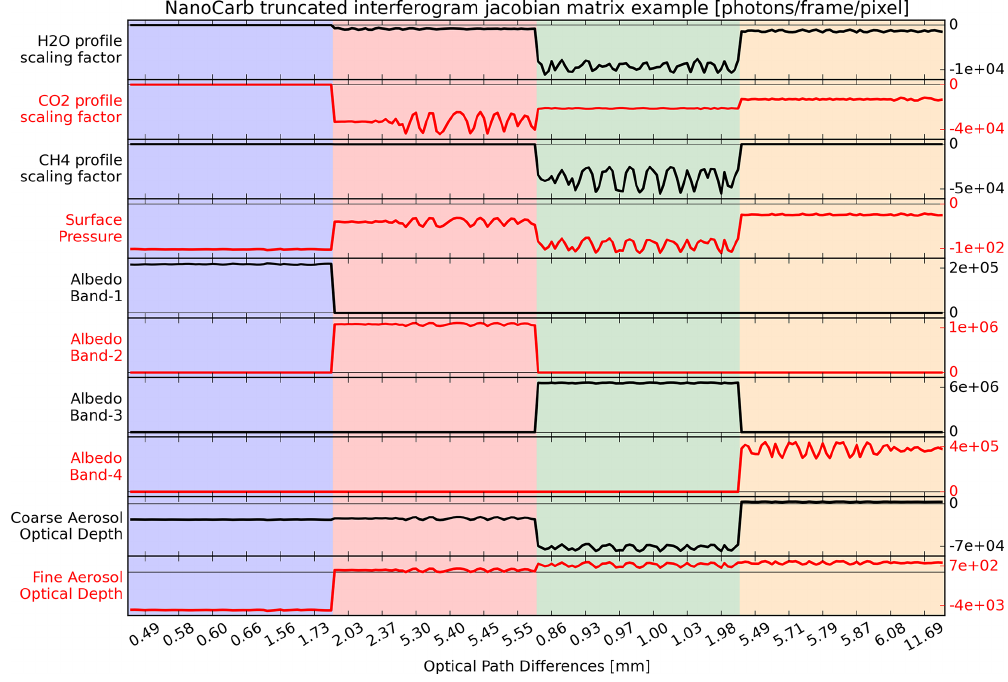
Figure 4. Example of a NanoCarb truncated interferogram Jacobian matrix for the 5AI state vector geophysical variables used in this work. It corresponds to the NanoCarb truncated interferogram shown in Fig. 2. Again, partial derivatives are plotted as a function of the OPD indices as the OPD sampling is very